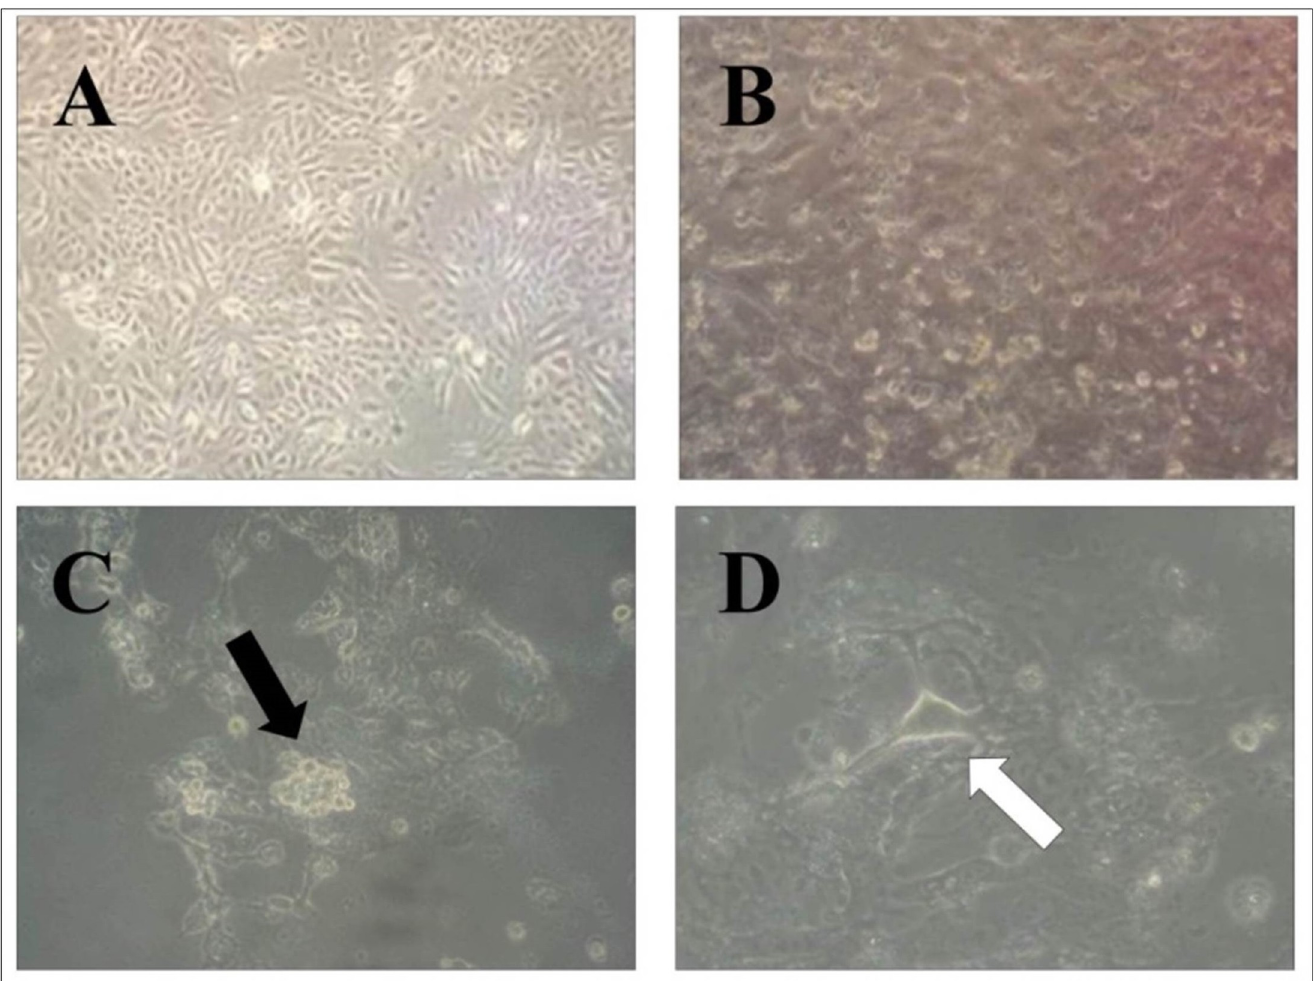
Fig 12. The photomicrographs of morphology changes of Vero cells before virus inoculation (A), at 24-h (B), 48-h (C), and 72-h (D) after virus inoculation observed at a magnification of 100x. The black arrow shows a giant cell formation and the white arrow indicates a cytopathic effect.